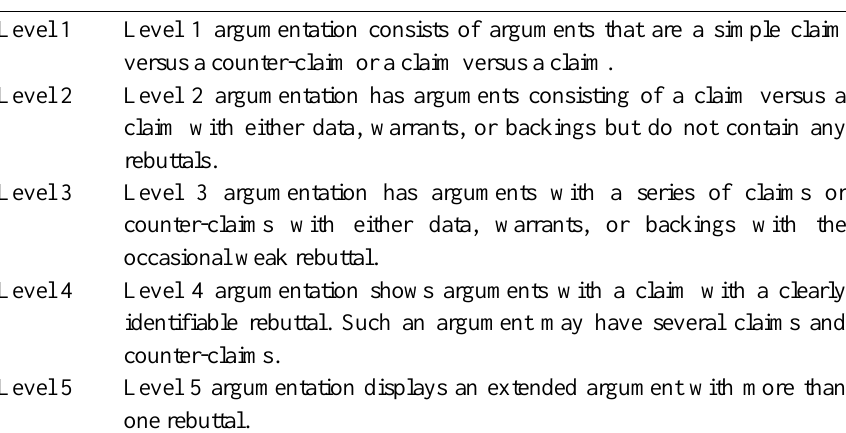
Analytical Framework used for assessing the Quality of Argumentation proposed by Erduran, Simon & Osborne (2004, p.